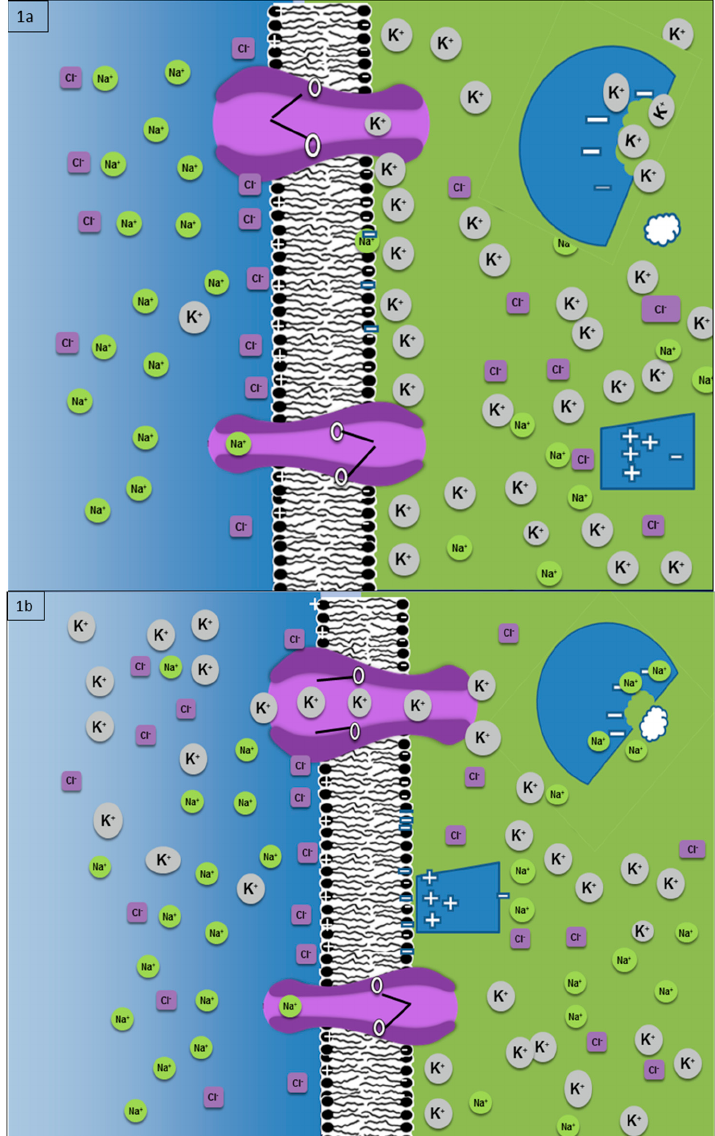
Figure 1. Information detected by the protein gate in a K + channel in the cell membrane opens the gate allowing rapid e ffl ux of most abundant mobile cation. ( a ) Baseline state with large transmembrane gradients in Na + , Cl − , and K + generated by ATP-dependent membrane pumps. In the cytoplasm (K + ), as the mobile cation with the highest concentration, is the primary shield of negative charges on the inner leaf of the cell membrane and reaction pocket of an enzyme (this neglects Ca 2 + and Mg 2 + , which can also serve as cation shields but are present in very low concentrations). The active site of the enzyme is too large to match the shape of the substrate, and the shielding of the inner leaf of the membrane does not allow it to attract the positive charges on the peripheral membrane protein. ( b ) Following an external perturbation that opens the K + channel, a rapid e ffl ux of K + briefly